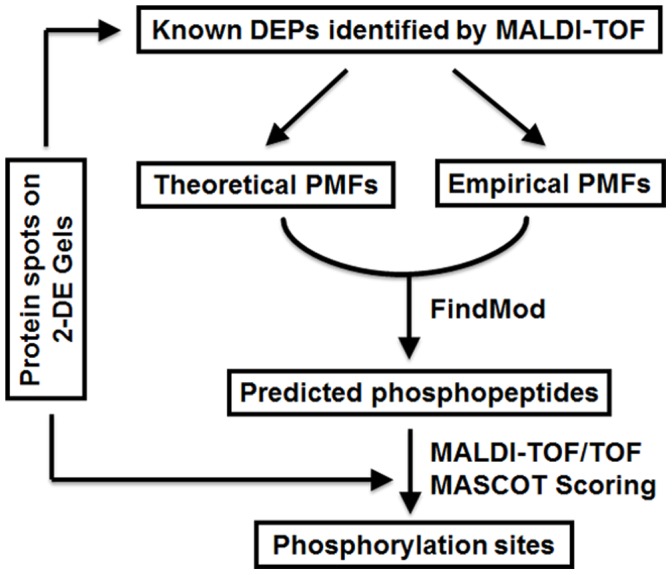
Flowchart of the 2-DE-based phosphorylation site identification method.Mass spectra and accurate amino acid sequence of the selected protein are analyzed by FindMod tool to predict the possible phosphopeptides, which are further confirmed by MS/MS and MASCOT scoring to elucidate the precise phosphorylation sites.